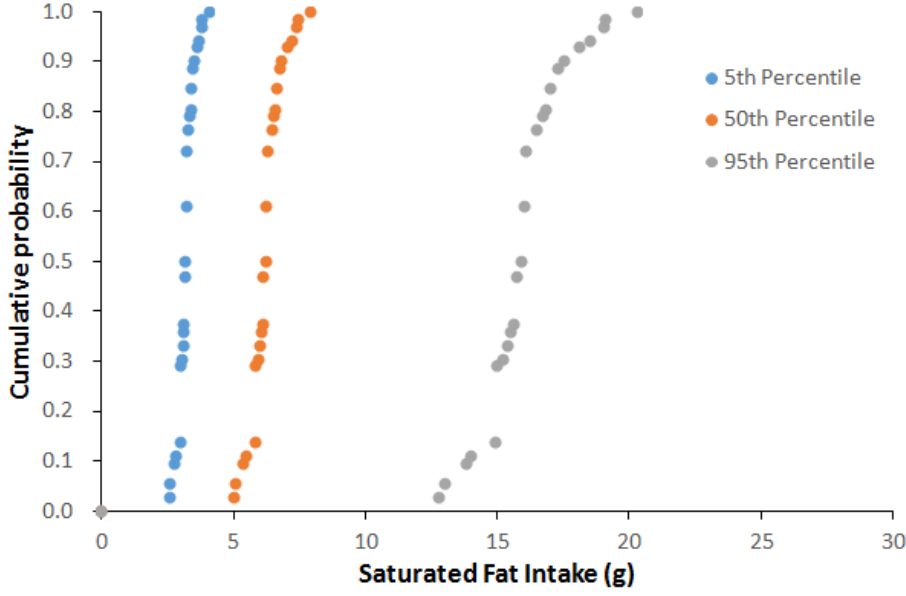
Figure 3. Cumulative probability of saturated fat (g) intake per capita and per day of Greek adults’ consuming feta cheese marketed in the Greek market for the fifth, 50th and 95th percentiles of daily consumption.